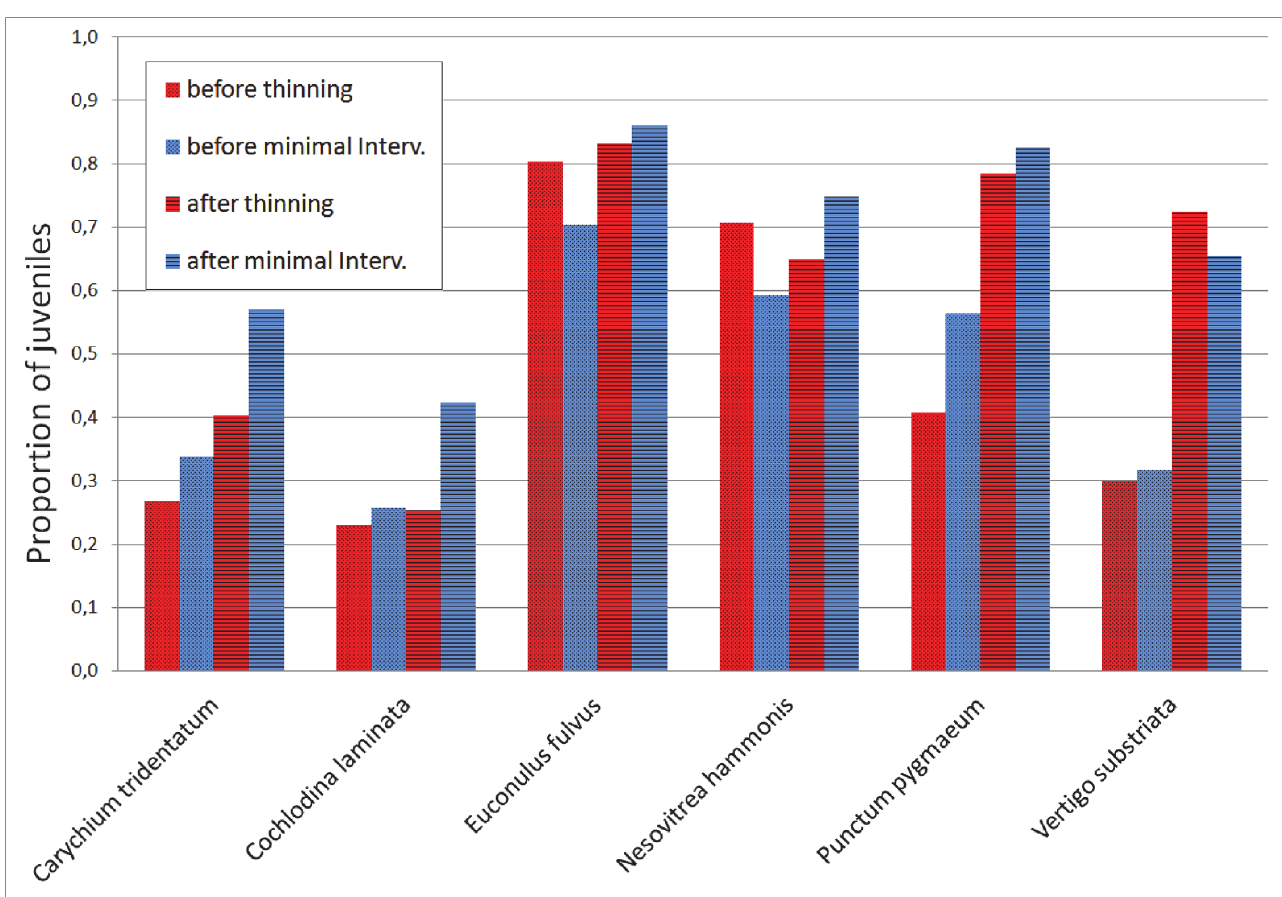
Fig 4. The overall proportion of juveniles for six species with sufficient samples. Data for thinning plots (pooled) and for minimal intervention plots (pooled; for details, see